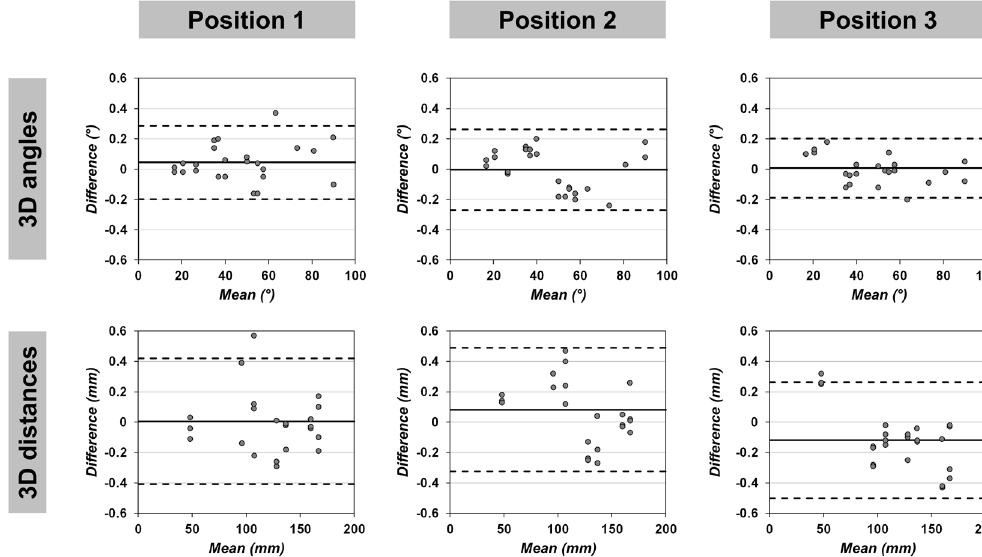
Figure 2. Bland-Altman plots for in vitro comparison between true values and 3D MRI measurements. Exemplary Bland-Altman plots for 3D angles and 3D distances in 3 different phantom positions are shown. Solid lines represent the mean of all differences (bias), dashed lines the 95% limits of agreement between the true values and the measurements on